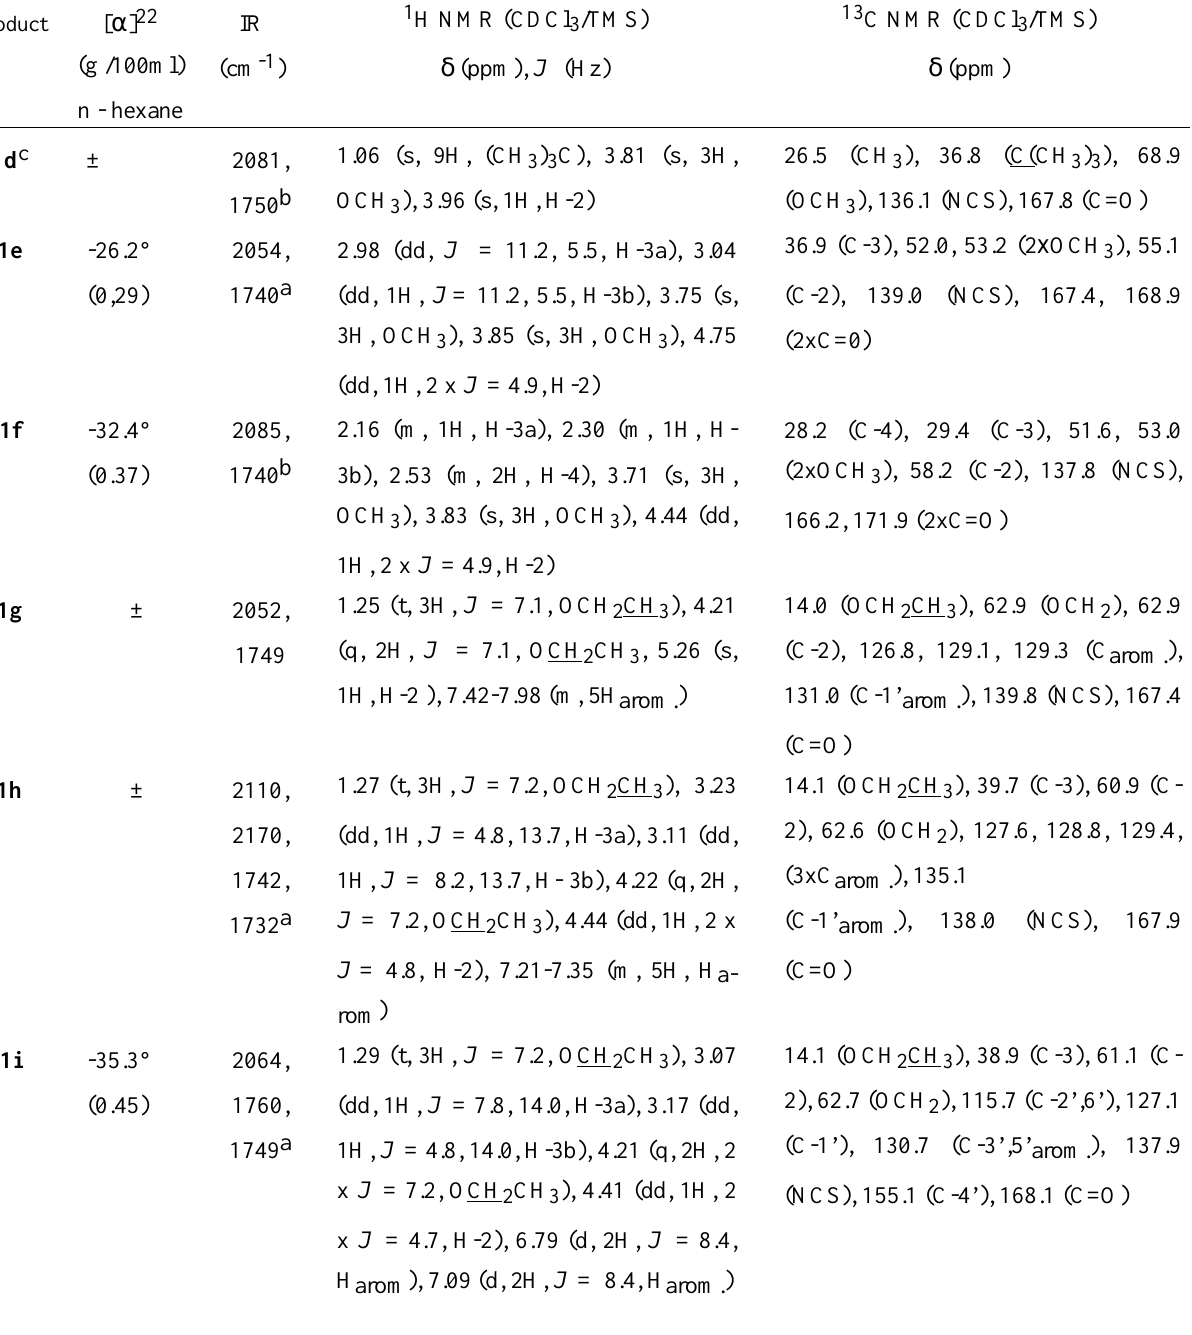
Table 1. Spectral Data of Isothiocyanates 1